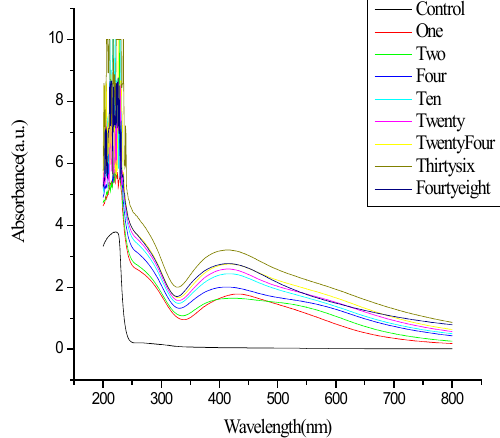
Fig. 2(b): UV-VIS Spectra of GS-RAgNPS at 3mM AgNO 3